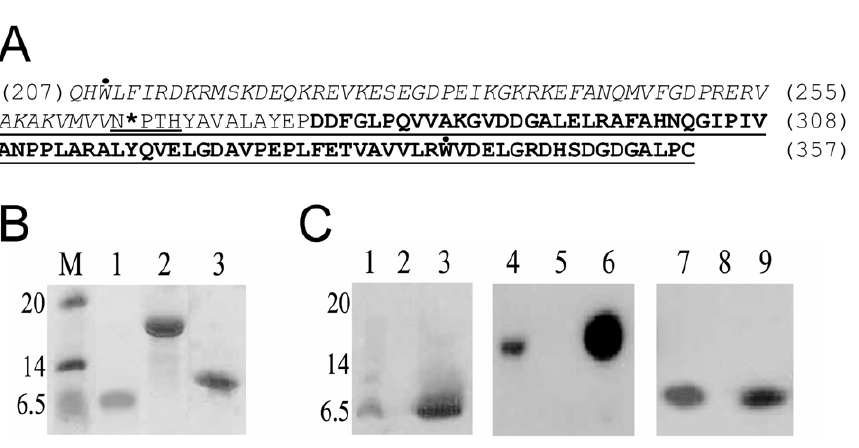
Figure 1. Expression of HrcU XAC C-terminal fragments. A ) Primary sequence of the C-terminal domain (residues 207-357) of HrcU XAC . Residues 207-264 are in italic and residues 277-357 are shown in bold . The underlined sequence was shown to interact with HrpB2 XAC in yeast two-hybrid assays [5]. In HrcU XAC_207-264 and HrcU XAC_207-357(AAAH) , residues Q207 and H208 were replaced with Met and Asp residues respectively. The highly conserved NPTH sequence is double-underlined and the cleavage site between N264 and P265 is indicated with an asterisk. The two tryptophan (W209 and W340) residues are indicated with a dot above their letter symbols. B ) Coomassie-stained SDS-PAGE of purified recombinant HrcU fragments. Purified HrcU XAC_208-264 (lane 1), HrcU XAC_207-357AAAH (lane 2) and HrcU XAC_His277-357 (lane 3). Molecular mass markers (M) are shown on the left with masses in kDa. C ) Western blots of purified HrcU XAC fragments (lanes 3, 6, 9) and of E. coli cell lysates before (lanes 2, 5, 8) and after (lanes 1, 4, 7) expression using the polyclonal antiserum raised against HrcU XAC_207-357AAAH . HrcU XAC_207-357 (lanes 1-3), HrcU XAC_207-357AAAH (lanes 4-6), HrcU XAC_His277-357 (lanes 7-9).